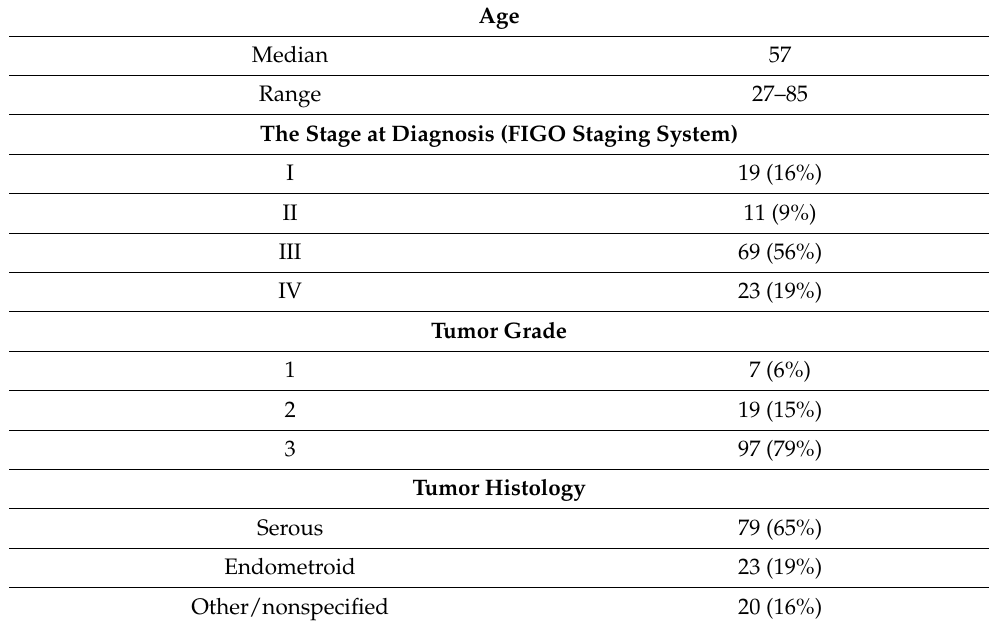
Table 2. Patients’